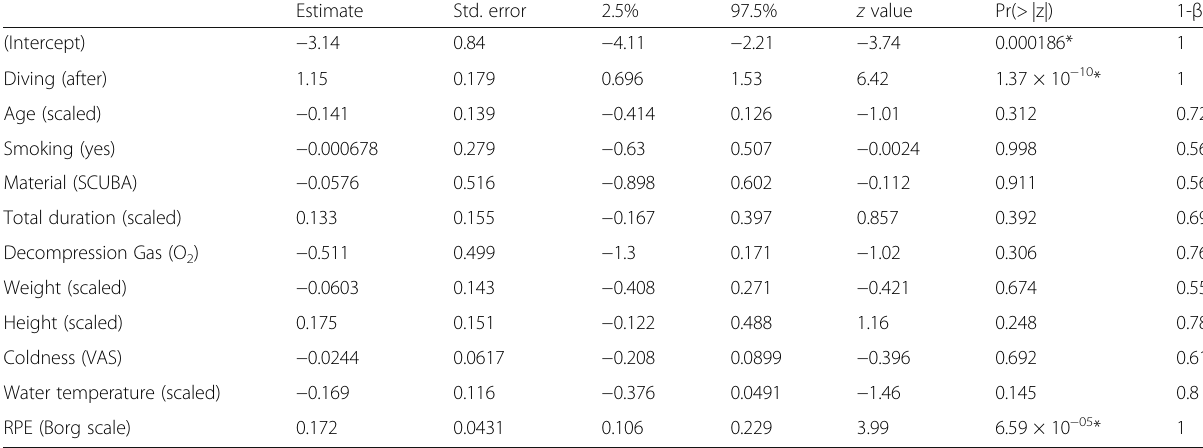
Table 2 Estimate, standard error of estimate, confidence intervals of estimate obtained by bootstrap, z value, p value, and post hoc power are represented for fixed effects of generalized linear mixed-effects model for the negative binomial family Estimate Std. error 2.5% z value Pr(> |z|) 1- β (Intercept)